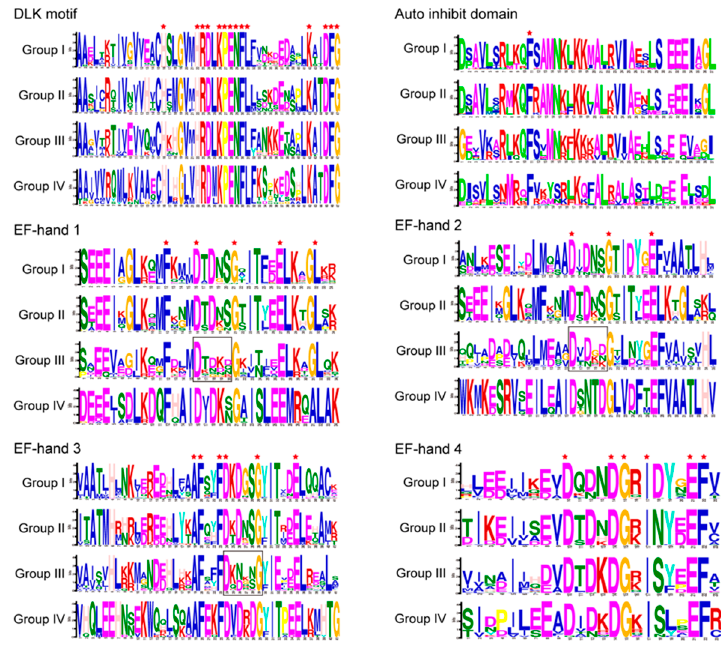
Figure 6. Comparison of sequence logos for conserved motifs of CPKs from the five Asteraceae species. Sequence logos of the consensus motifs were created using MEME online software. The height of each letter represents the frequency of amino acids at corresponding position. The red star means all CPK members have the exact same amino acid in corresponding site. Black frames showed the amino acid sites with much lower conservation in EF-hand 1, 2 and 3 of group III.